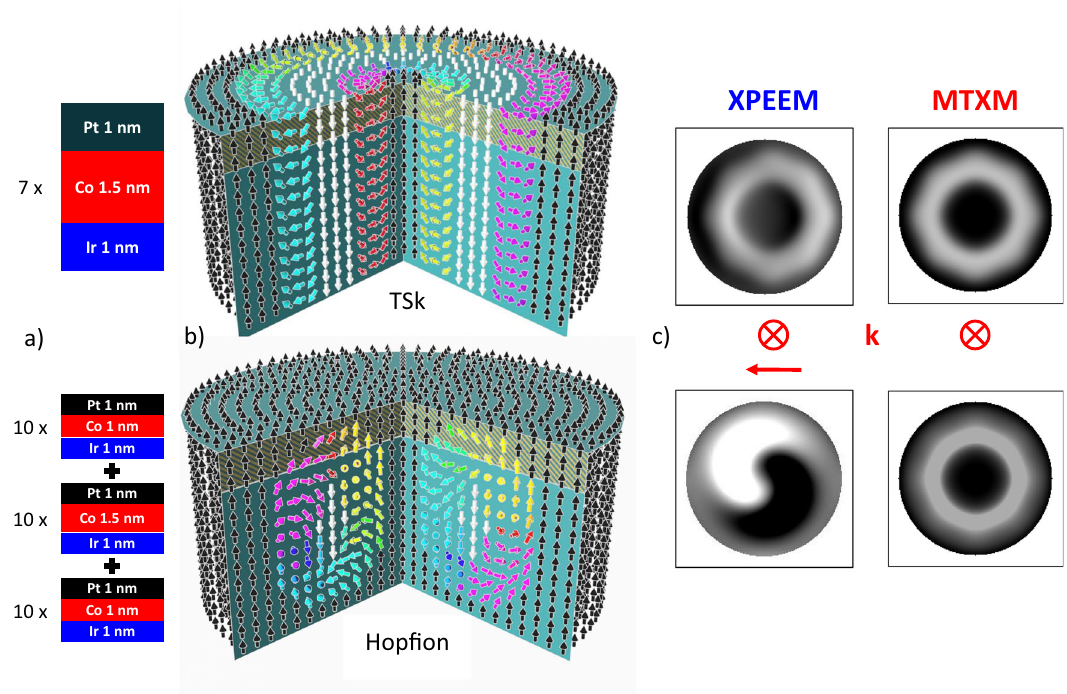
Fig. 1 Spin texture of a 2 π TSk and a Q = 1 Hop fi on. a Schematics of the Ir/Co/Pt multilayer systems (S7, S30) used in this study. b Schematical drawing of the spin texture of a 2 π TSk (top) and a symmetric Q = 1 Hop fi on (bottom). The yellow-shaded region near the top indicates the approximate depth sensitivity of X-PEEM. c Simulated X-PEEM (left) and MTXM (right) signals for a TSk (top) and a Hop fi on (bottom). The direction of the photon angular momentum (k) is indicated for X-PEEM (in-plane and out-of-plane) and MTXM (only